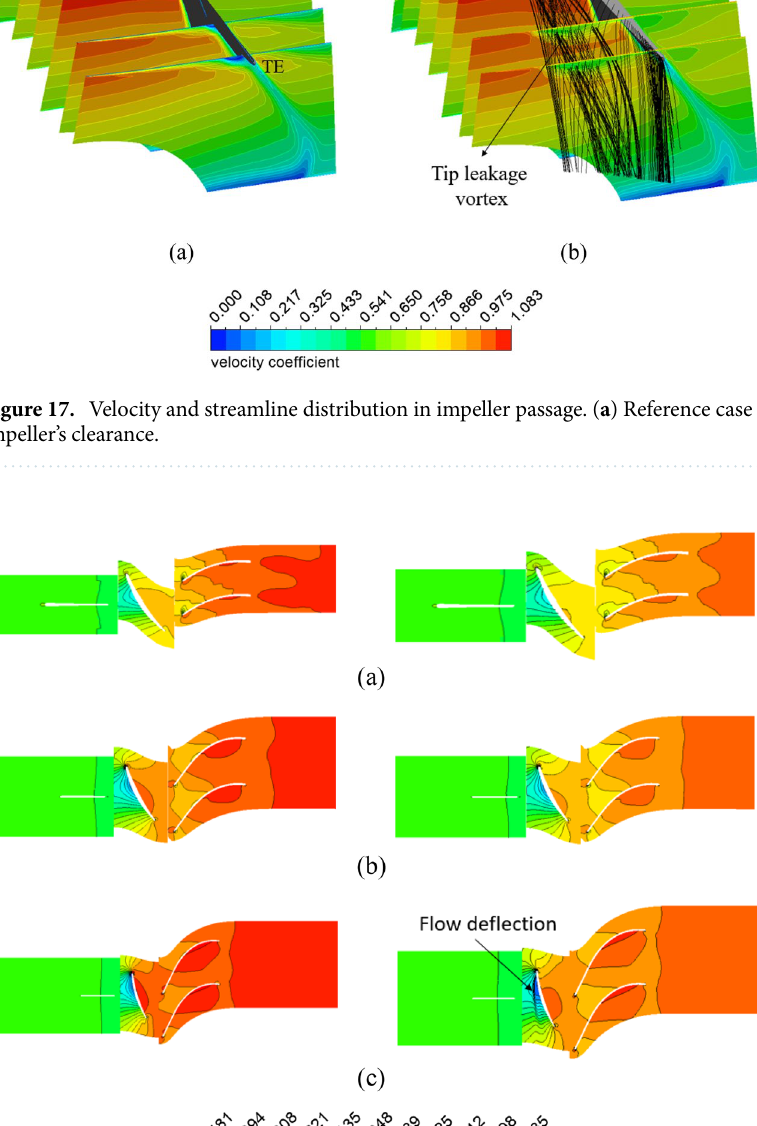
decrease in the area of the low-velocity region. This change is shown in Fig. 21 by the absolute flow angle at the LE of the impeller. As the IGV’s setting angle increases, the absolute flow angle gradually decreases, making the flow more compatible with the blade angle and increasing performance. Figure 22a,b depict the blade loading distribution at 50% span of the impeller and DV, respectively. The pres- sure is non-dimensionalized using the maximum pressure value of the reference case. The pressure distribution